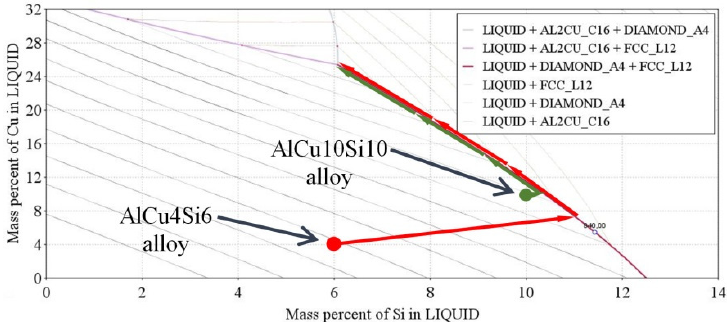
Figure 12. Ternary phase diagram—Al-Cu-Si system. Liquidus projection with the marked solidification path (Scheil–Gulliver solidification): red arrows represent the AlCu4Si6 alloy and green arrows represent AlCu10Si10.